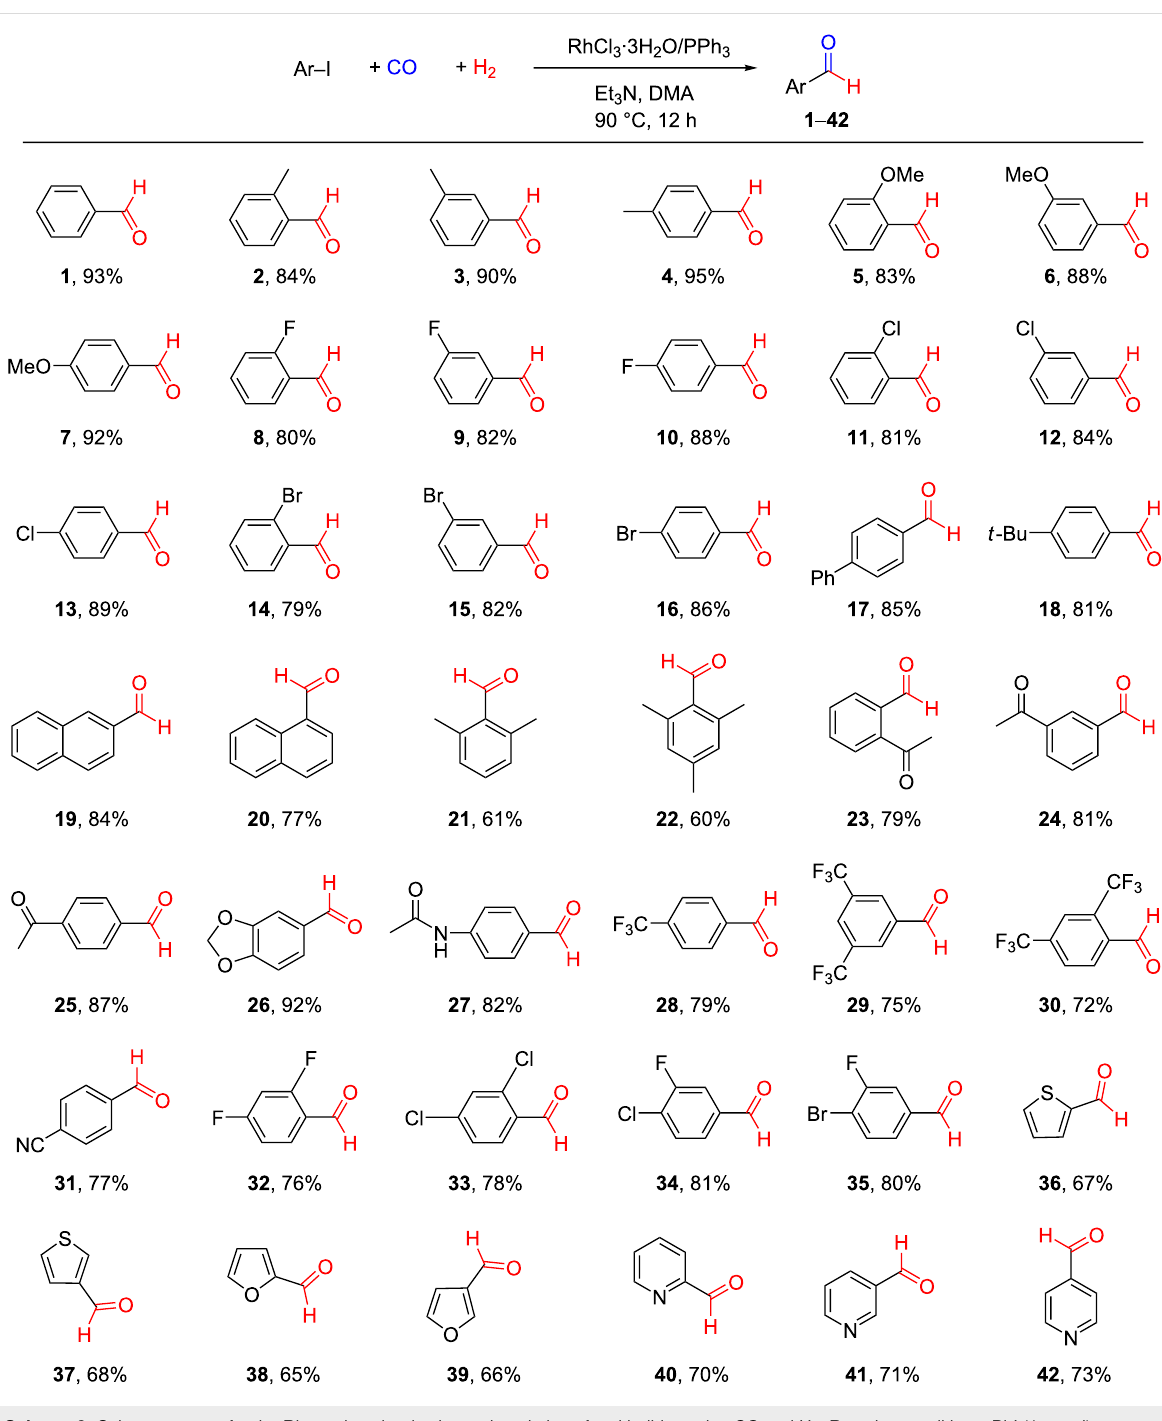
substituents (F, Cl, Br), these were also compatible with the reaction system, affording 79 − 89% yields of the halogenated ar- omatic aldehydes 8 – 16 . Iodobenzene derivatives with phenyl or tert -butyl groups displaying larger steric hindrance in the para -